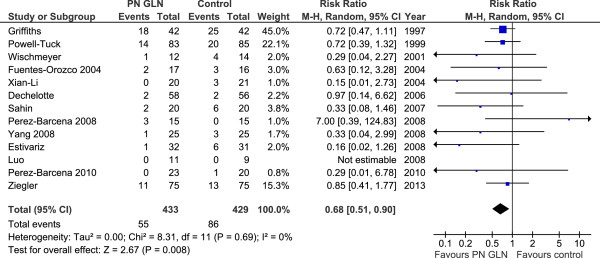
Hospital mortality.